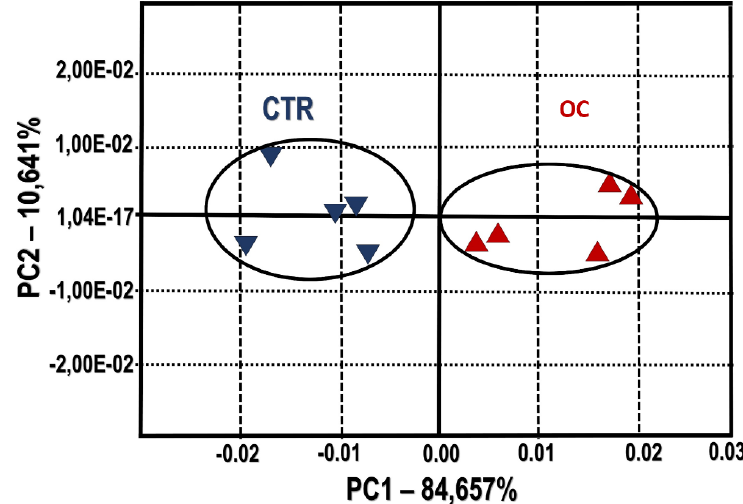
Figure 2. Principal Components Analysis (PCA) plot of cheese samples. CTR group: five cheese wheels after 60 days of ripening obtained from the milk of dairy cows fed concentrate without olive cake supplements. OC group: five cheese wheels after 60 days of ripening obtained from the milk of dairy cows fed concentrate with olive cake supplements. Discrimination index = 59. The two principal as